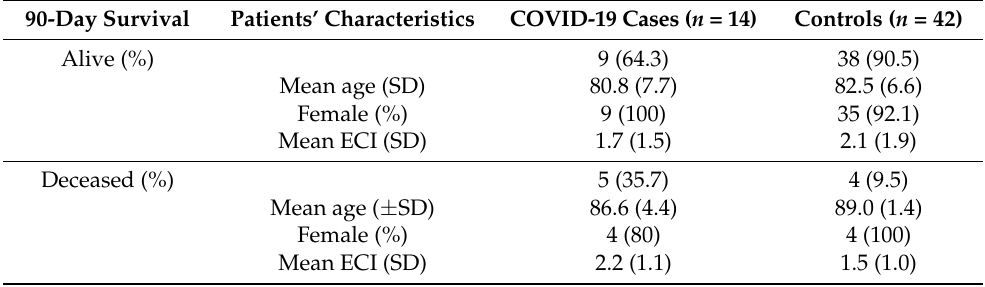
Table 5. Ninety-day survival of cases and controls and patients’ characteristics stratified for 90-day status (alive or deceased). No statistically significant differences have been found.